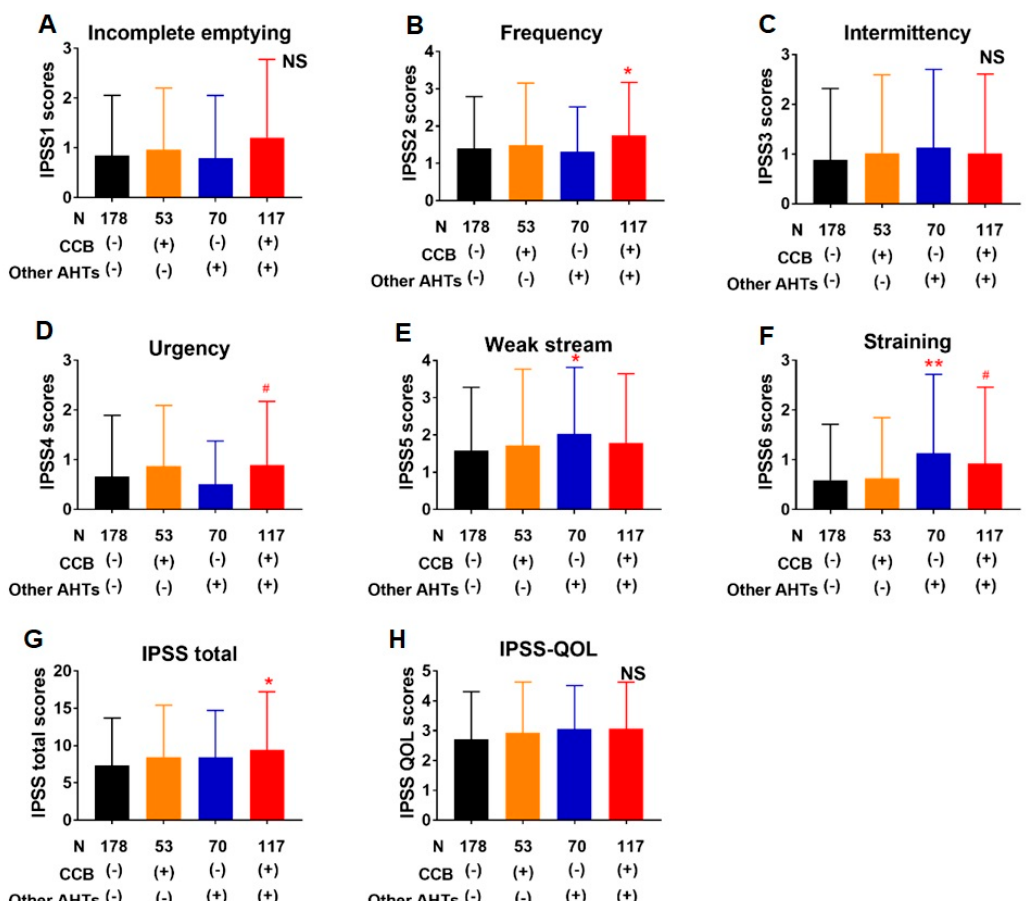
Figure 3. Comparison of respective IPSS items other than IPSS item 7, nocturia (( A ) incomplete emptying, ( B ) frequency, ( C ) intermittency, ( D ) urgency, ( E ) weak stream, and ( F ) straining), IPSS total score ( G ) and IPSS-QOL ( H ) in patients taking CCB alone ( n = 53, orange columns), other AHT(s) ( n = 70, blue columns), and CCB plus other AHT(s) ( n = 117, red columns) compared to those not taking AHTs ( n = 178, black columns). Frequency ( B ), urgency ( D ), straining ( F ), and IPSS total score ( G ) were higher in patients taking CCB plus other AHTs compared to those not taking AHTs. Weak stream ( E ) and straining ( F ) were higher in patients taking AHTs other than CCB compared to those not taking AHTs. AHT(s) antihypertensive agents, CCB calcium channel blocker, IPSS international prostate symptom score, QOL quality of life, NS not significant. # p < 0.1, * p < 0.05, ** p < 0.01. A B C D